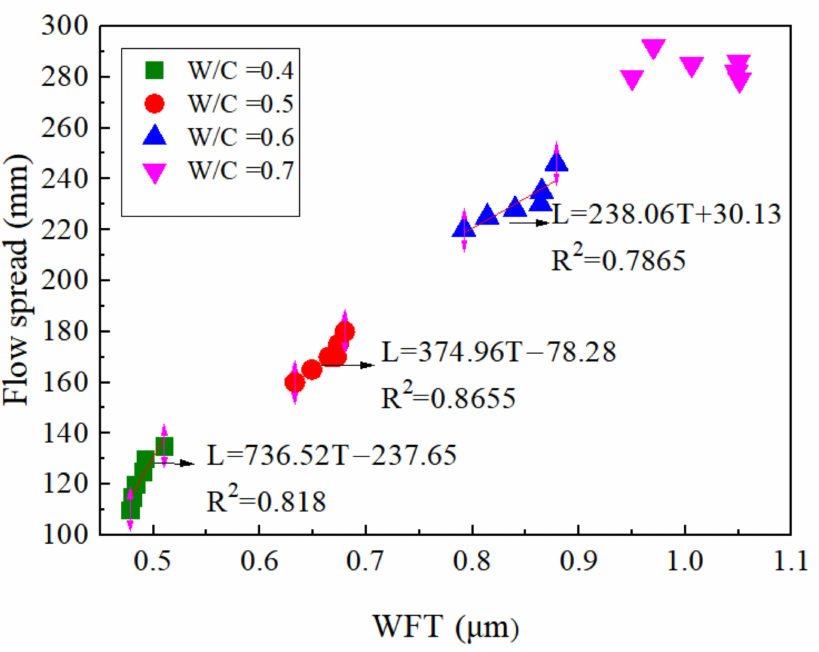
Figure 12. WFT vs. flow